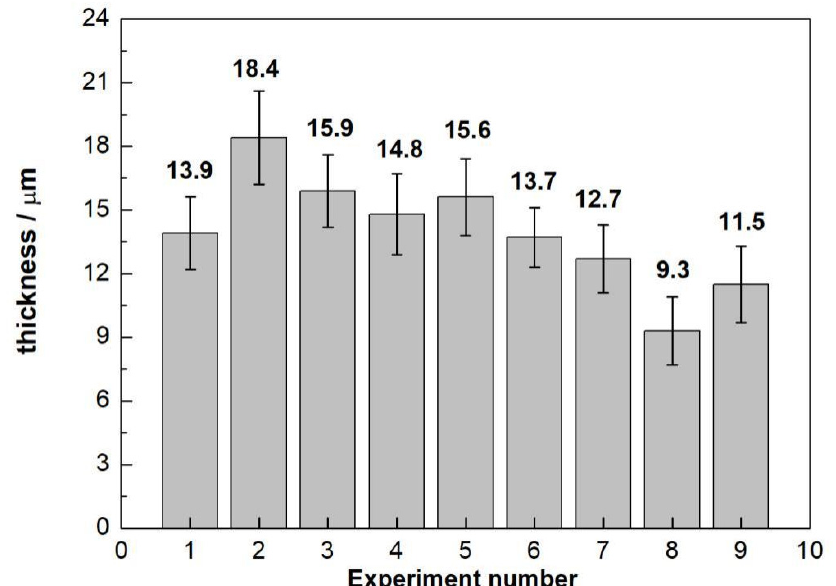
Figure 1. The film thickness of each test.